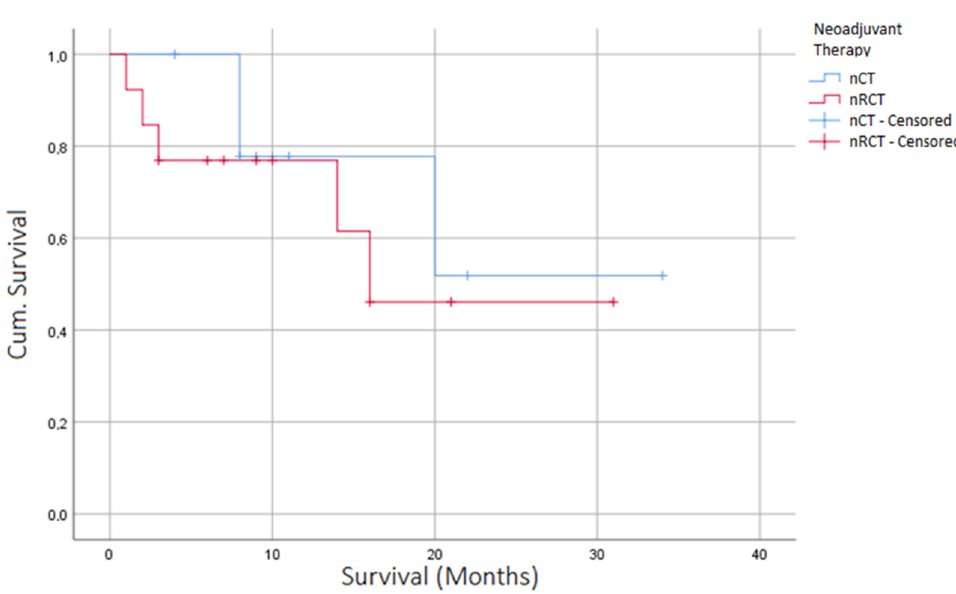
Figure 2. Kaplan–Meier curve depicting overall survival of patients after EVT for AL, stratified according to neoadjuvant therapy (nRCT/nCT).